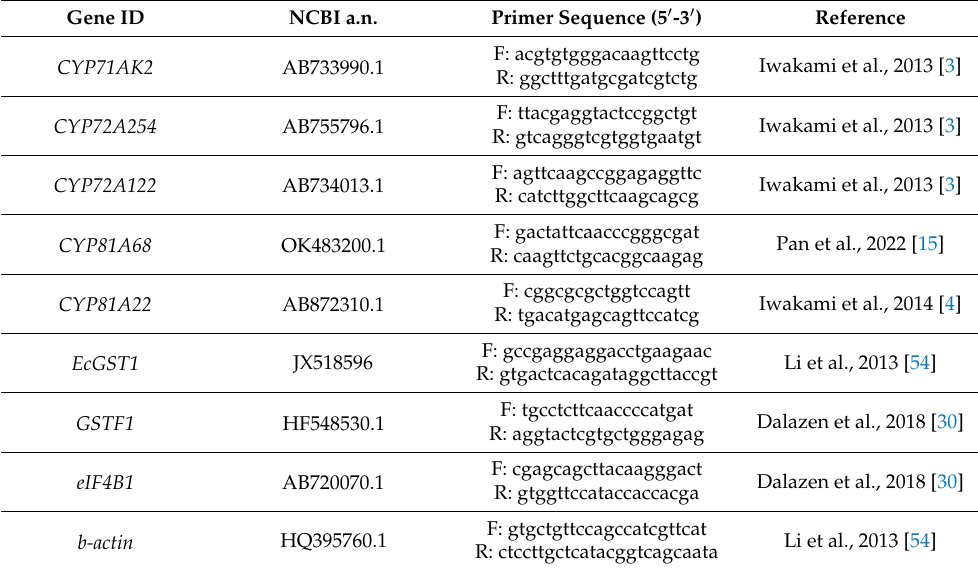
Table 2. Nucleotide sequences of the primers used for qRT-PCR analysis of CYP450, GST and eIF4B genes’ expression in Echinochloa crus-galli . Gene ID NCBI